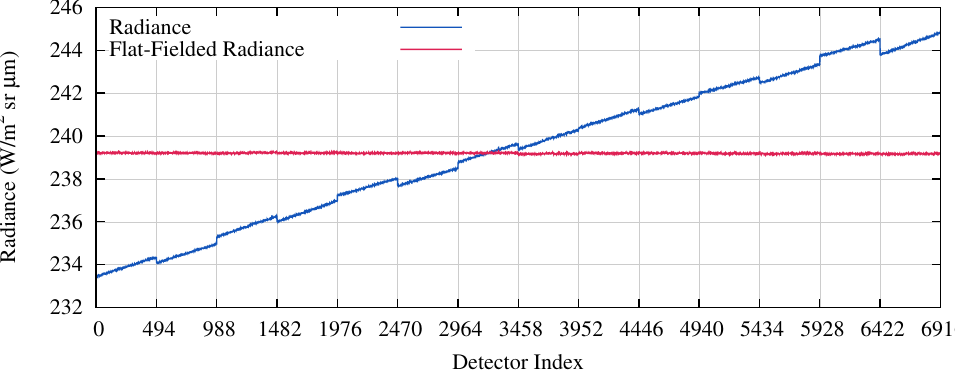
Figure 7. OLI response to the solar diffuser and the flat-fielded results for the NIR band on April 18, 2014. The nonuniformity scale factors used to flat-field for the broad FPM effects were re-derived using on-orbit data. The per-detector variation remains after this flattening, though the on-orbit scale factors do a good job removing the different FPM